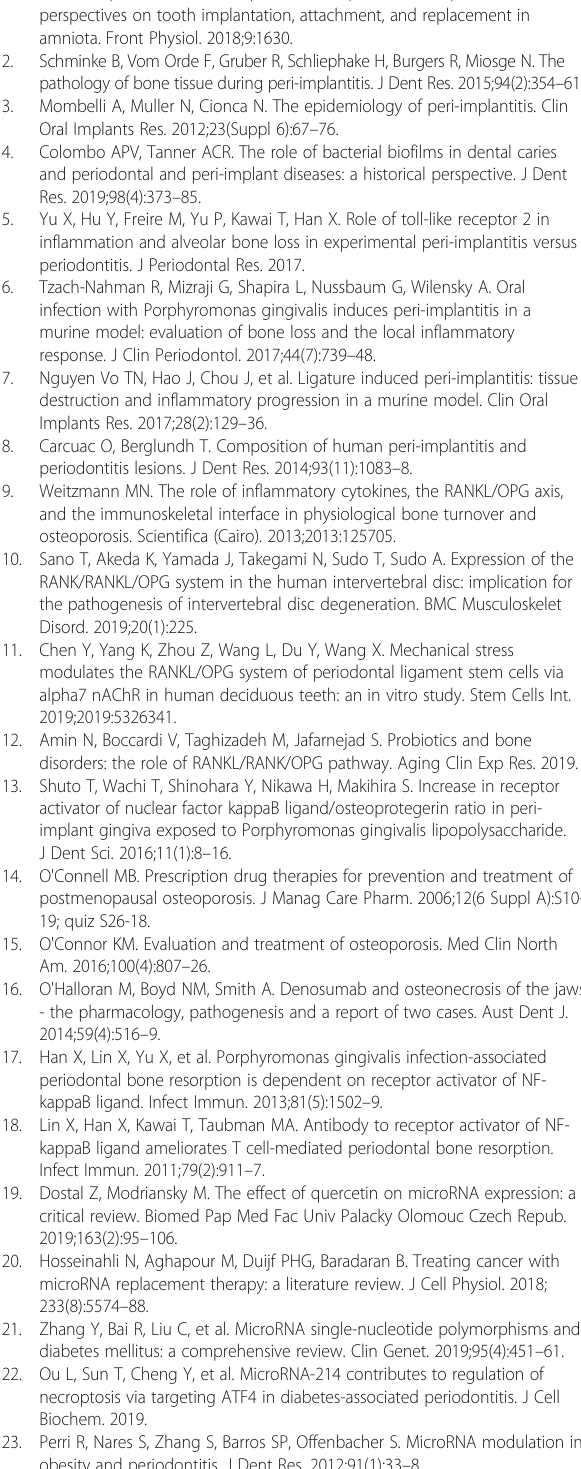
Additional file 1: Supplemental Table S1. The numerical data of all